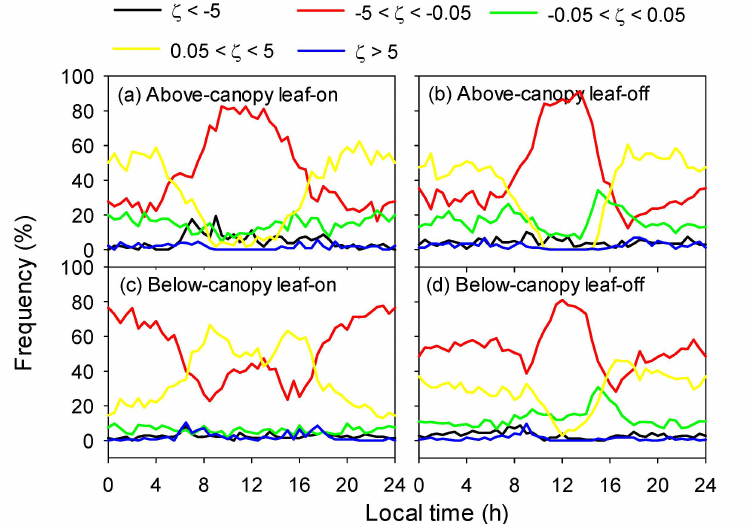
Figure 5. Diurnal courses of the net radiation above (48 m) and bellow (2 m) the canopy during the leaf-on and leaf-off seasons from May of 2013 to April of 2014. ( a ) 48 m for leaf-on season, ( b ) 48 m for leaf-off season, ( c ) 2 m for leaf-on season, and ( d ) 2 m for leaf-off season. Open circles are mean values, filled circles are the median and error bars indicate the range between the 25 and 75 percentile, respectively. The dashed lines are zero radiations.